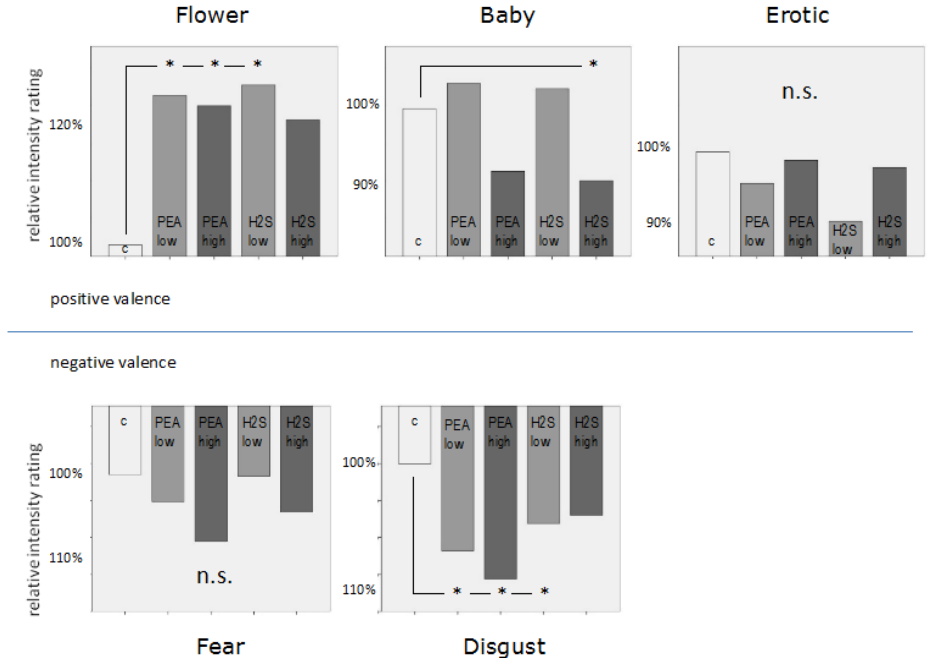
Figure 2. Bar diagrams for each picture category demonstrating differences in valence intensity rating for all olfactory conditions in relation to olfactory control.